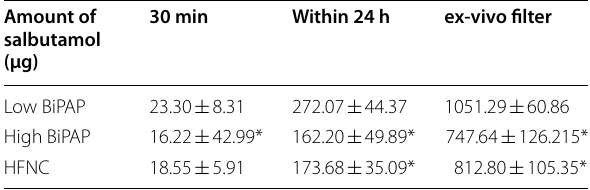
Table 3 The amount of salbutamol (µg) collected in urine samples 30 min and within 24 h post sample and on ex-vivo filter ( n 12). Values are expressed as mean =